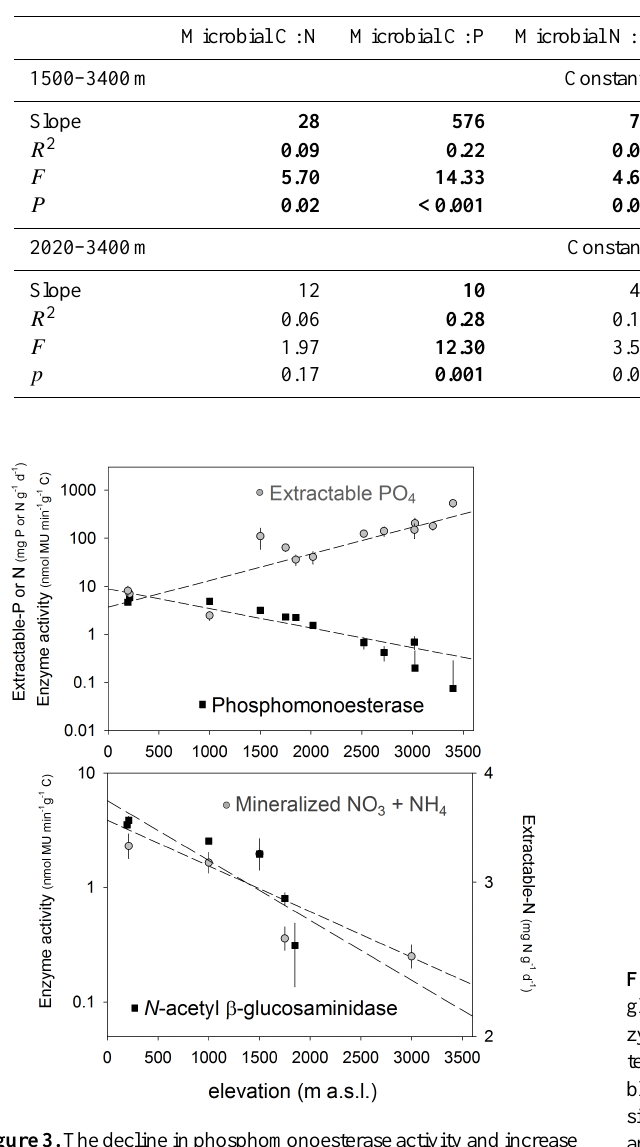
Table 4. Relationships between elevation and microbial and enzymatic carbon (C), nitrogen (N) and phosphorus (P) ratios, in organic soils only (sites 1500–3400ma.s.l.) and in soils of constant parent material (sites 2020–3400ma.s.l.). The relationships between elevation and microbial and enzymatic carbon, nitrogen and phosphorus ratios for all sites across the gradient are shown in Figs. 3 and 5, respectively. Significant relationships are in bold ( p ≤ 0.05).